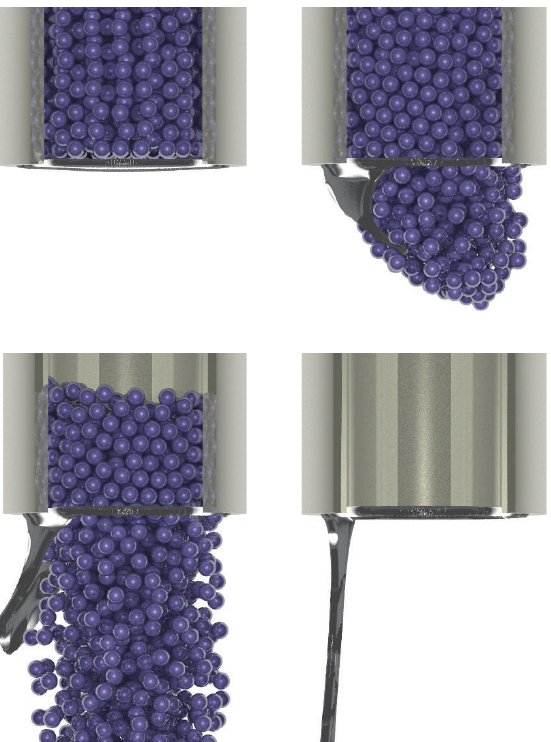
Figure 10: Combined seal and particle simulation with a 0.25 mm seal, rupturing under the weight of the